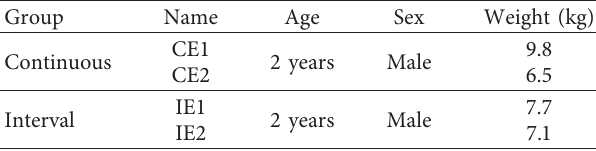
Table 1: Baseline Beagle’s information by